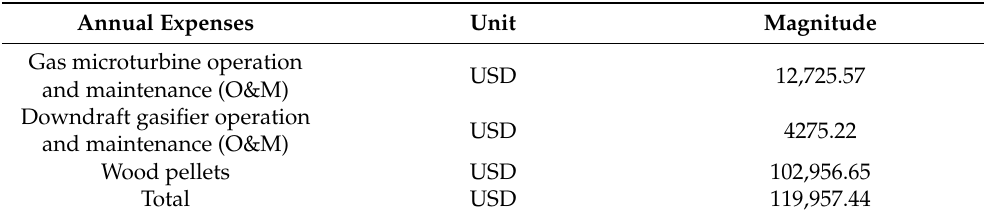
Table 9. Annual costs for the gas microturbine and downdraft gasifier-based generation system using oxygen-enriched air as a gasification agent.